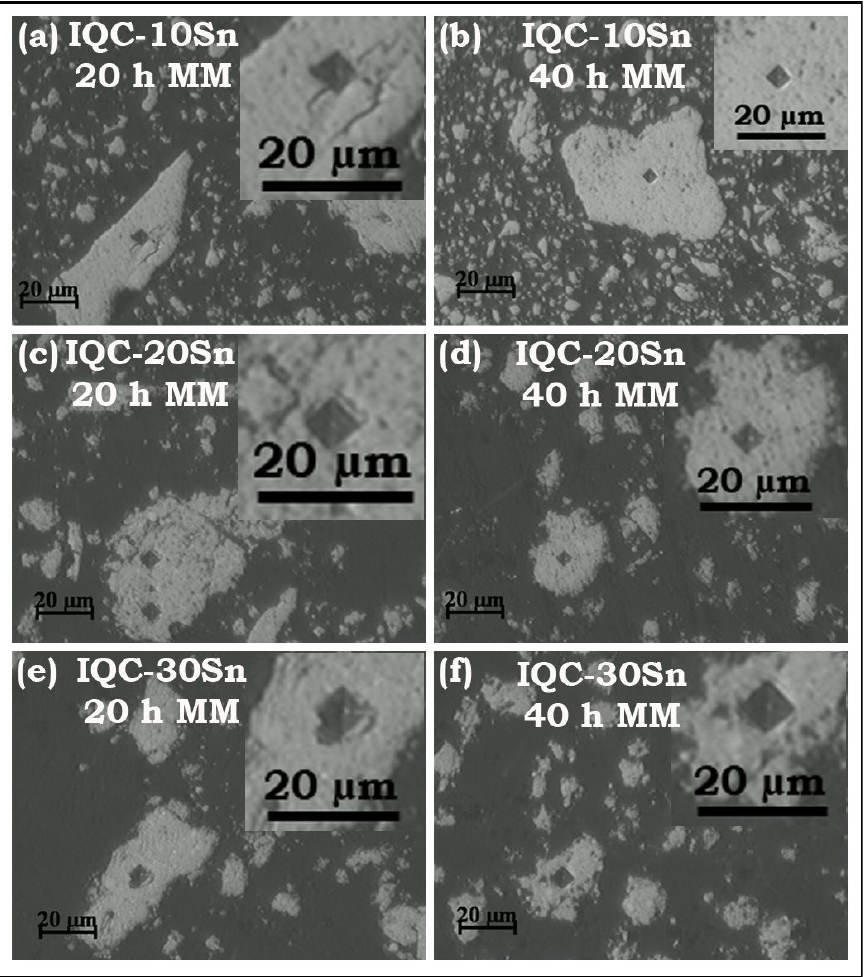
Figure 4. Optical micrograph showing indentation marks on the ( a , b ) IQC-10Sn, ( c , d ) IQC-20Sn and ( e , f ) IQC-30 Sn nanocomposite powder MM for 20 h and 40 h. The IQC-Sn nanocomposite powders were consolidated using pressureless sintering (usually referred to as conventional sintering) at 800 ℃ (1073 K) for 10 h. The phase formation in IQC-10Sn-PS and IQC-30Sn-PS pressureless-sintered samples can be ascertained through the XRD pattern shown in Figure 5. The phases formed in the IQC- 20Sn-PS were similar to the IQC-30Sn-PS. Therefore, the XRD pattern pertaining to IQC- 10Sn-PS and IQC-30Sn-PS were only shown in the Figure 5. It is clear from the XRD pattern that the IQC phase retained its identity even after pressureless sintering, as evident from the presence of all the major reflections of the IQC phase. The IQC phases in IQC-Sn were found to be FCI IQC, as evidenced by the presence of the (311111) peak shown in Figure 5. The IQC matrix partially transforms to a minor amount of λ and B2 - type phases during sintering. The presence of the λ -Al 13 Fe 4 phase can be confirmed through the presence of the major reflection ( 7 � 13) at d~2.0778 Å, as shown in the Figure 5. The peak intensity of ( 7 � 13) at d~2.0778 Å of the Al 13 Fe 4 phase is higher for IQC-10Sn- PS than for IQC-30Sn-PS. Similarly, the presence of B2-type phases in the IQC-Sn pressureless-sintered composite was ascertained through the presence of (110) and (200) major peaks at d~2.056 Å and d~1.447 Å, respectively. The intensity of the B2-type phase is more in comparison to the λ -phase in IQC-30Sn-PS. The phase fraction of the λ -phase is more comparable to the B2-type phase in IQC-10Sn-PS. The ordering of the B2-type phase will be difficult to ascertain through XRD. The (100) superlattice reflection of the B2-type phase at d~2.90 Å coincides with Sn’s (200) reflection at d~2.91 Å. However, in